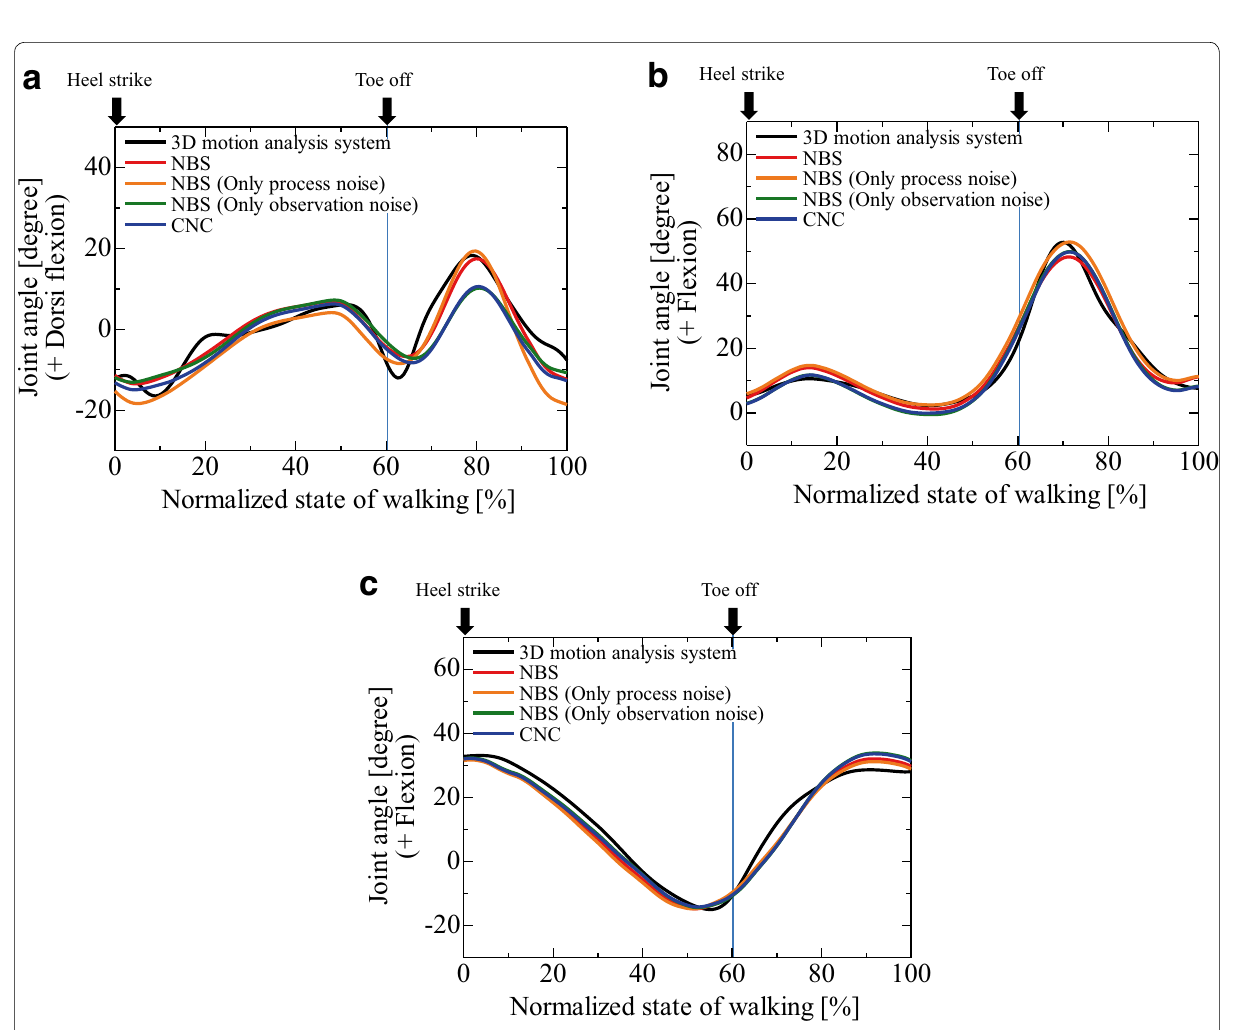
Fig. 3 Left lower limb joint angles during walking obtained using optical 3D motion analysis system, the extended Kalman filter using NBS, NBS (Only observation noise), NBS (Only process noise), and the extended Kalman filter using CNC (participant A). a The ankle joint angle. b The knee joint angle. c The hip joint angle.